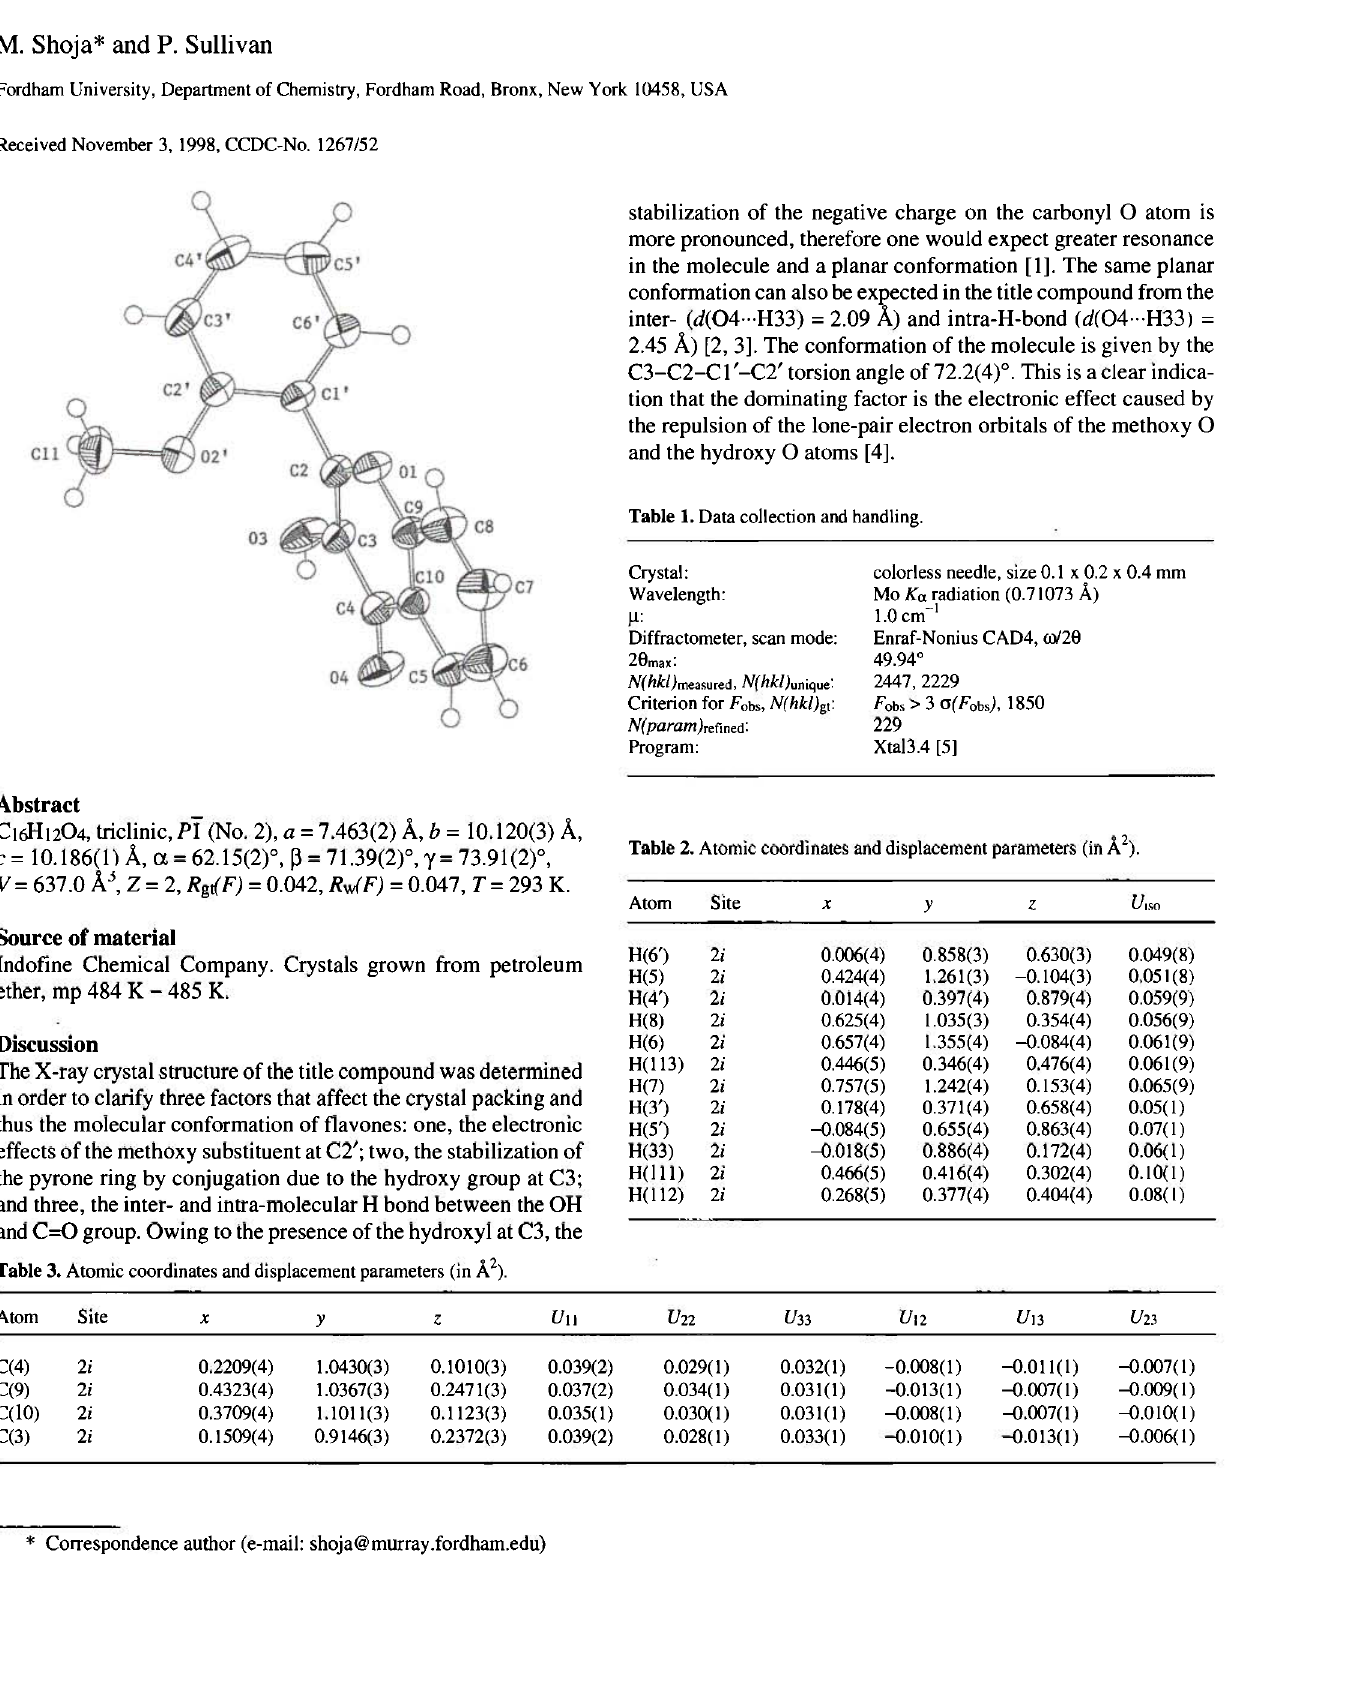
Table 1. Data collection and handling.